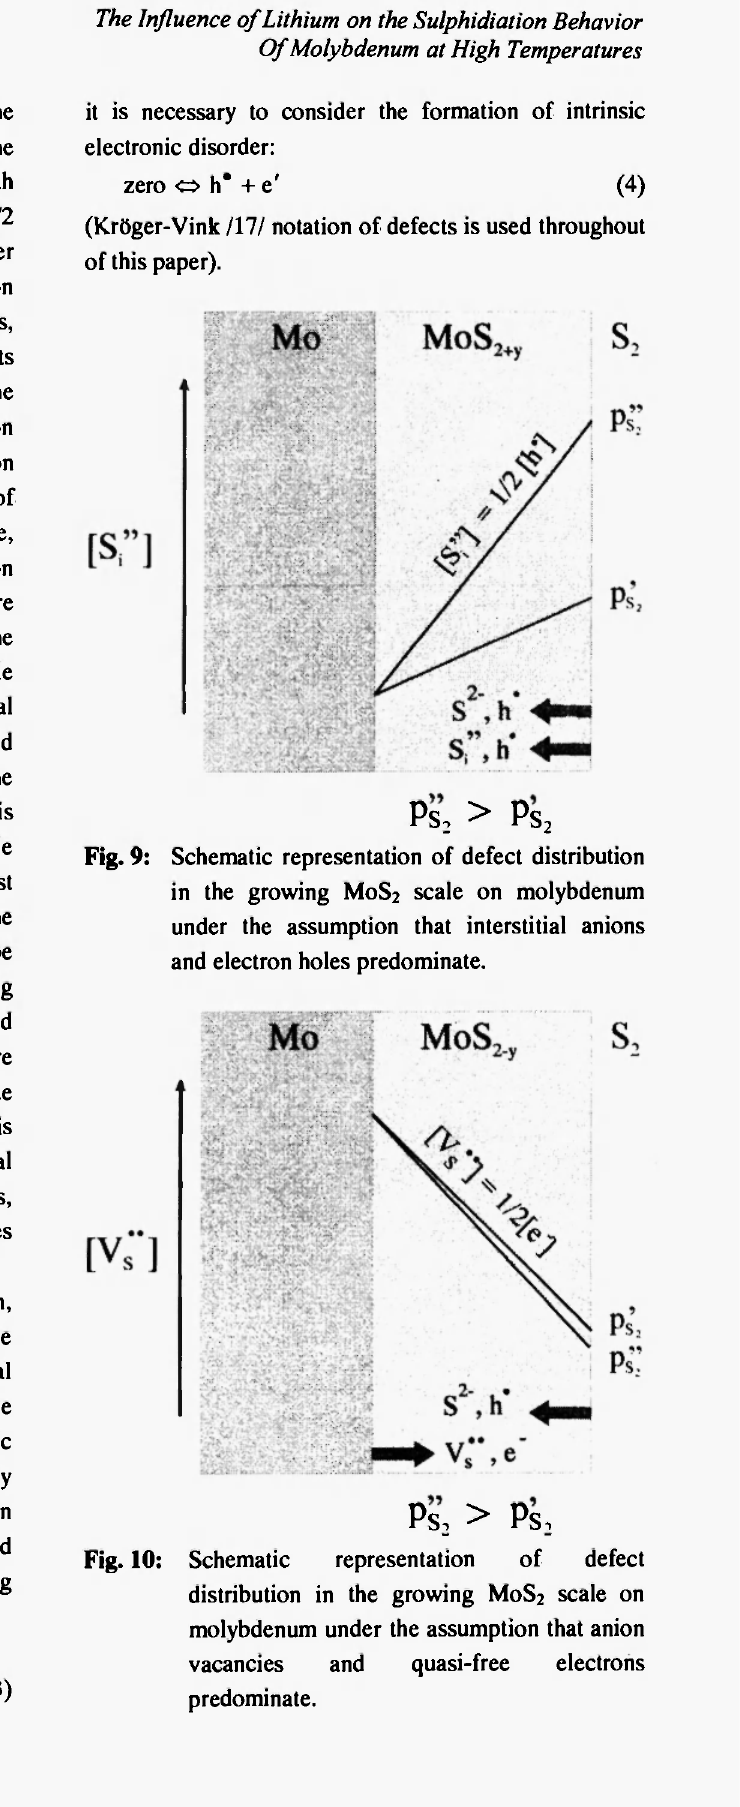
Fig. 10: Schematic representation of defect distribution in the growing MoS 2 scale on molybdenum under the assumption that anion vacancies and quasi-free electrons